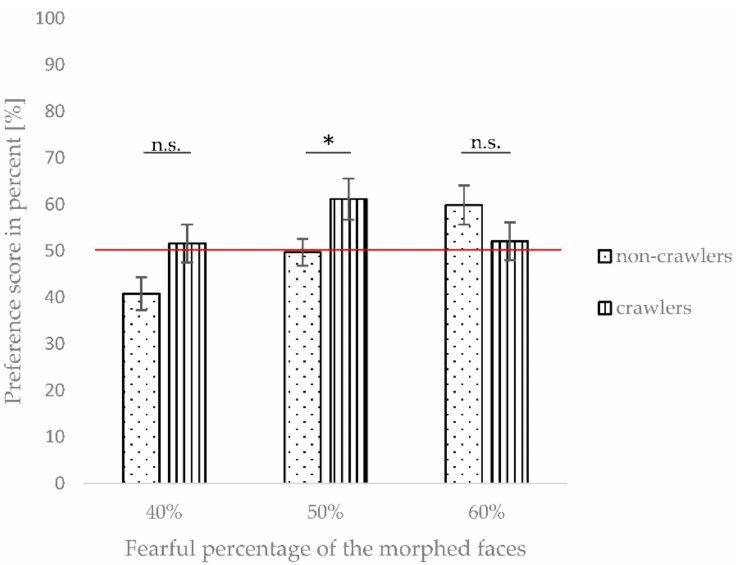
Figure 6. The preference scores for 40%, 50%, and 60% fearful morph levels for crawling and non- crawling infants. Error bars indicate the standard error of the mean. * indicates a p -value < 0.05, and n.s. (non-significant) indicates p -values >